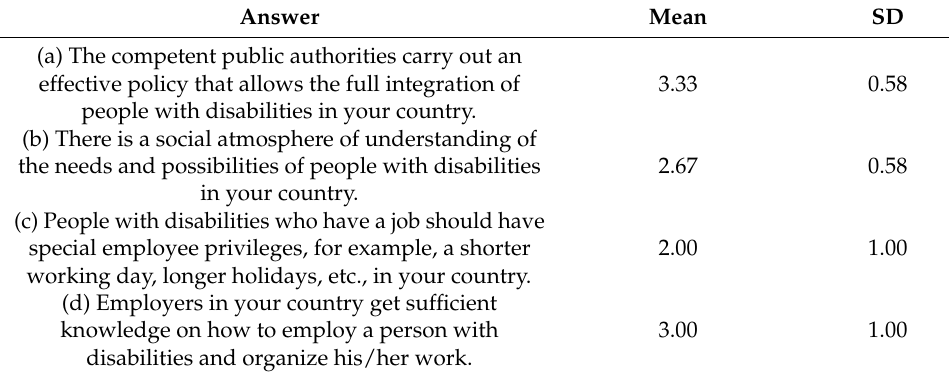
Table 14. In your opinion, answer the following questions on a scale of 1 to 4, with 1 being “definitely not” and 4 being “definitely